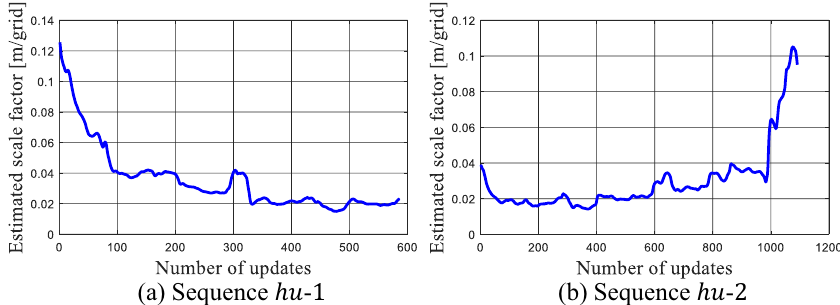
Figure 14. Estimated scale factor in the tests on manually collected dataset.